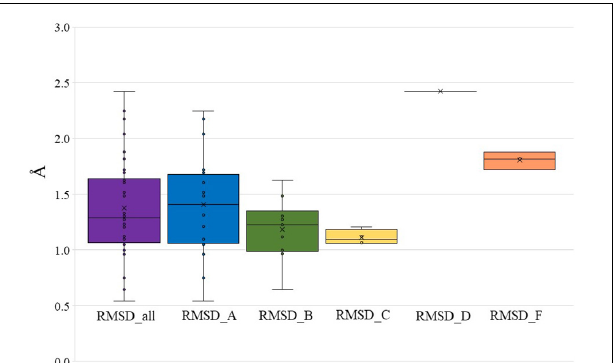
FIGURE 2 | RMSD between modeled structures and experimental structures for all GPCR classes, class A, B, C, D, and F (presented in Supplementary Table 2 ). The boundary of the box closest to zero indicates the 25th percentile, a black line within the box marks the median, and the boundary of the box farthest from zero indicates the 75th